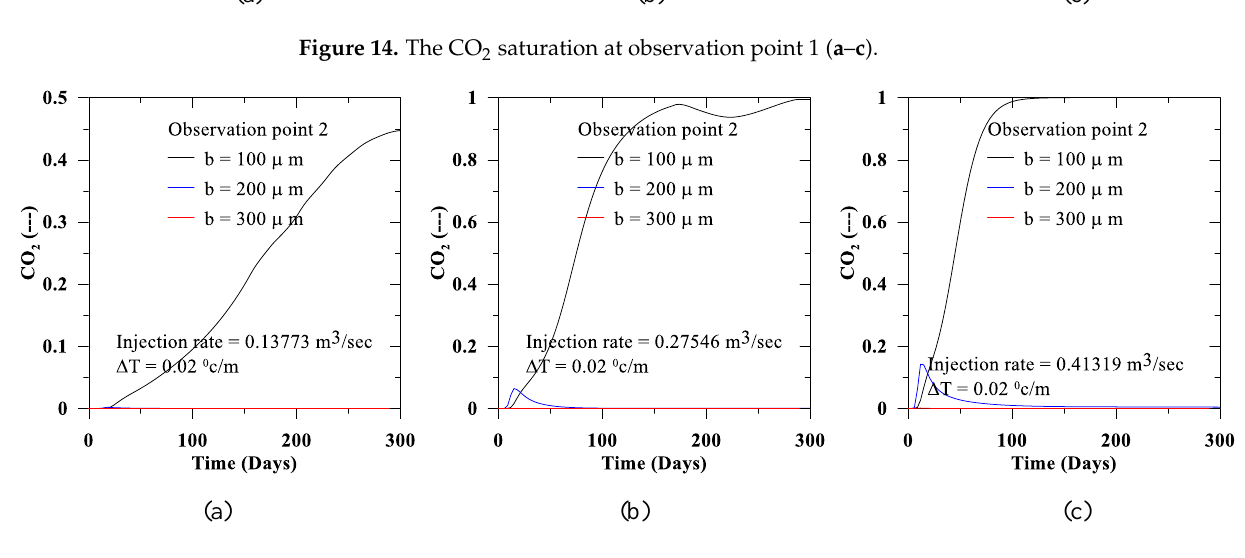
Figure 15. The CO 2 saturation at observation point 2 ( a – c ).